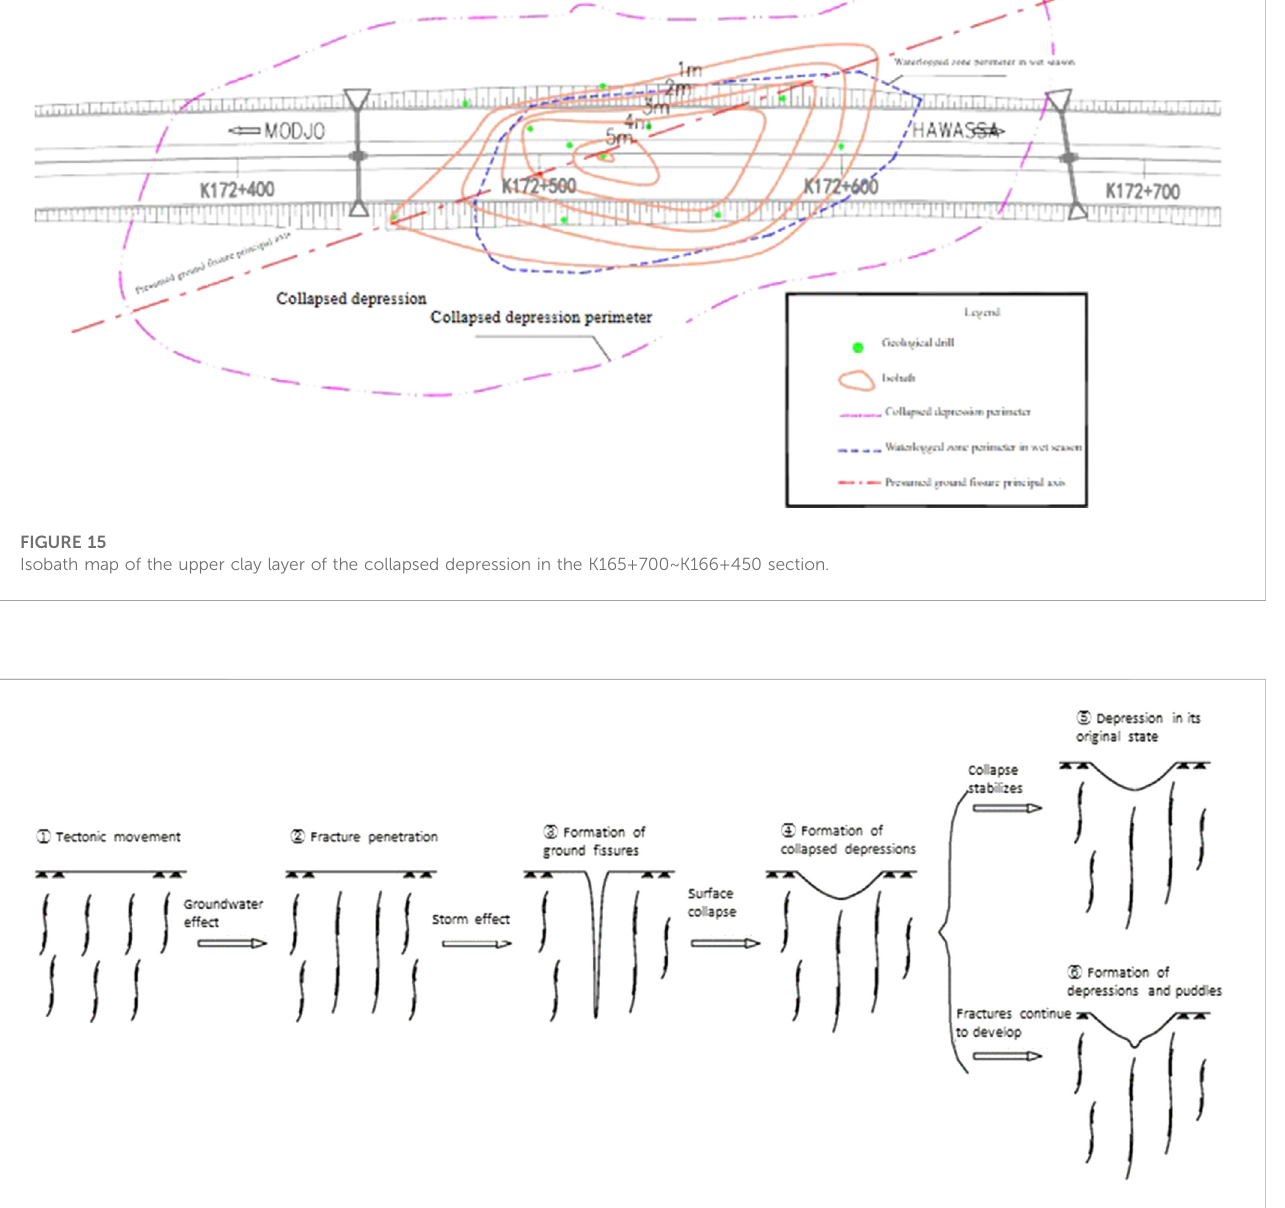
FIGURE 16 Diagram of ground fi ssure